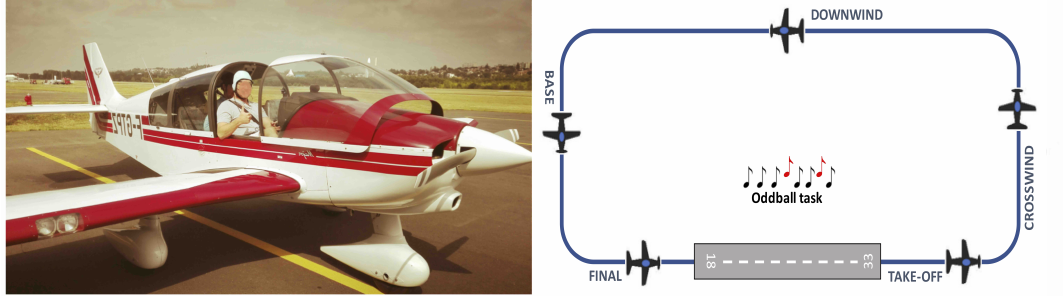
Figure 1. Left —ISAE-SUPAERO DR400 aircraft at Lasbordes airfield. Right —Experimental scenario: the pilots had to perform two traffic patterns (low and high load) along with an auditory oddball